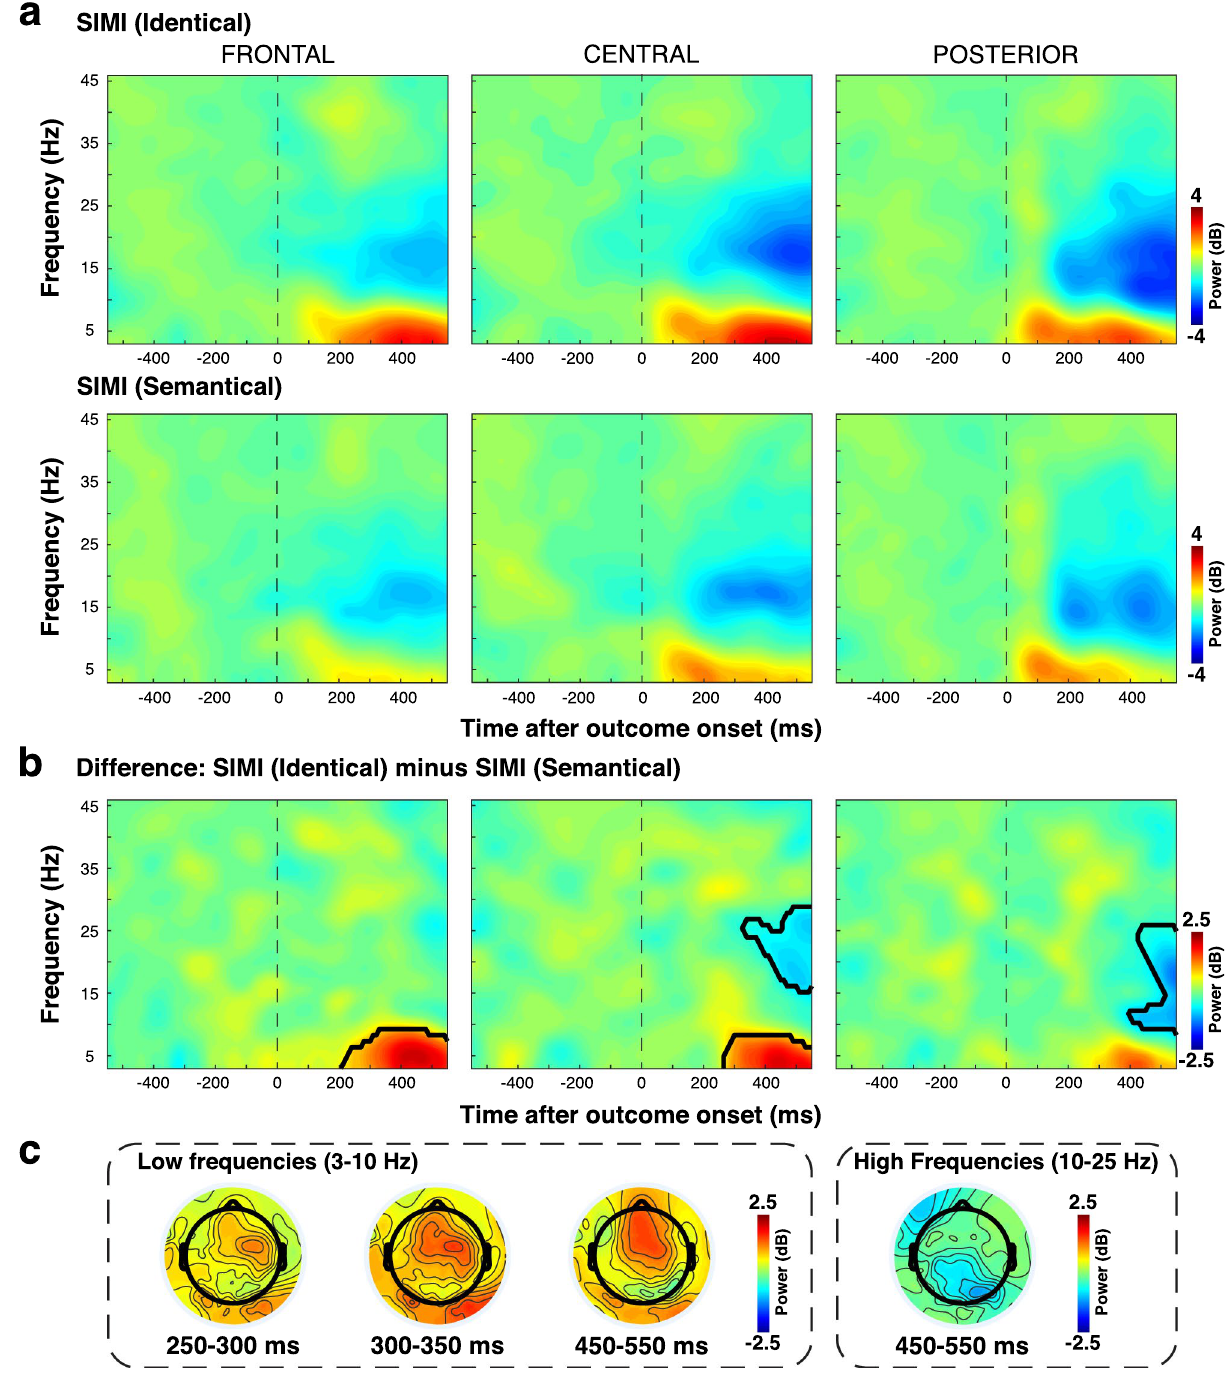
Figure 5. Electrodes-wise time–frequency analysis. ( a ) Power activation following outcomes SIMI presentation in condition identical (upper) and semantical (lower) at frontal (left), central (middle) and posterior (right) clusters of electrodes. ( b ) Power differences between SIMI (identical) and SIMI (semantical) at frontal (left), central (middle) and posterior (right) clusters of electrodes. Black lines indicate clusters of significant difference (p < 0.05; cluster corrected). ( c ) Topographical distribution of the power difference between SIMI (identical) and SIMI (semantical) at early and late time intervals for both low and high frequencies. The time intervals were based on the timing of distinct maps obtained in segmentation